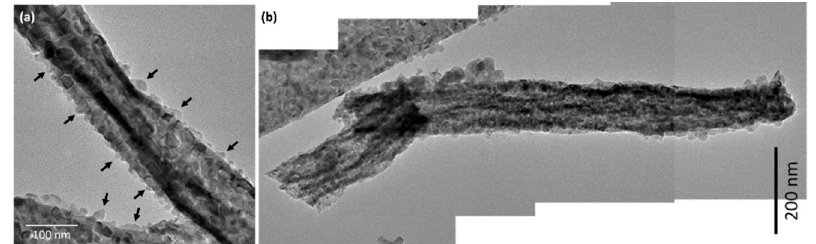
Figure 6. ( a , b ) TEM image of CeO 2 -CuCrO 2 nanofiber.